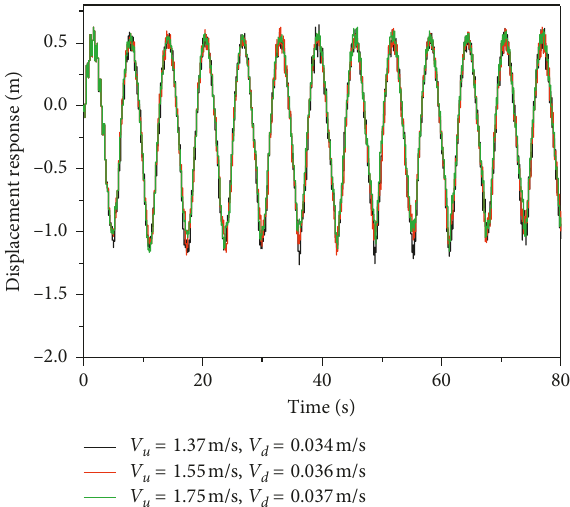
Figure 8: Effect of coupling on longitudinal vibration.